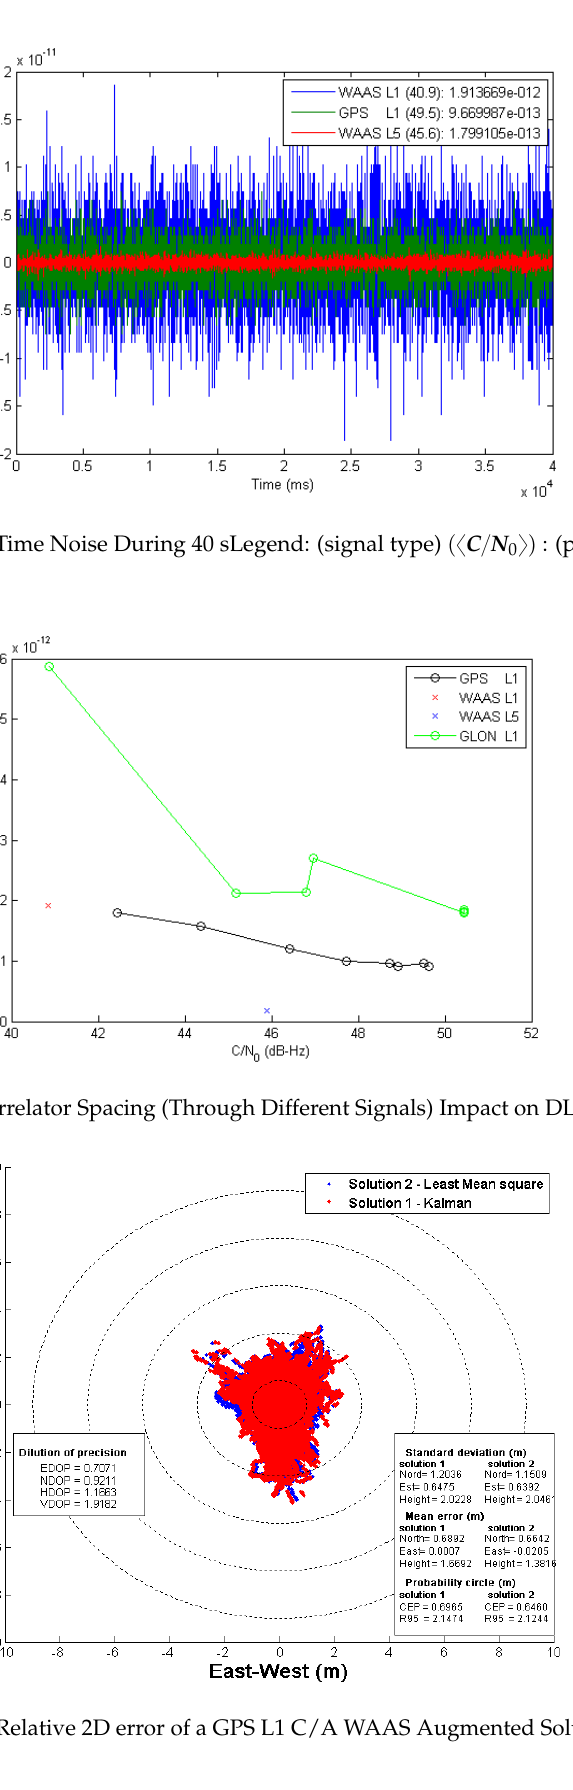
Figure 13. Relative 2D error of a GPS L1 C/A WAAS Augmented Solution.